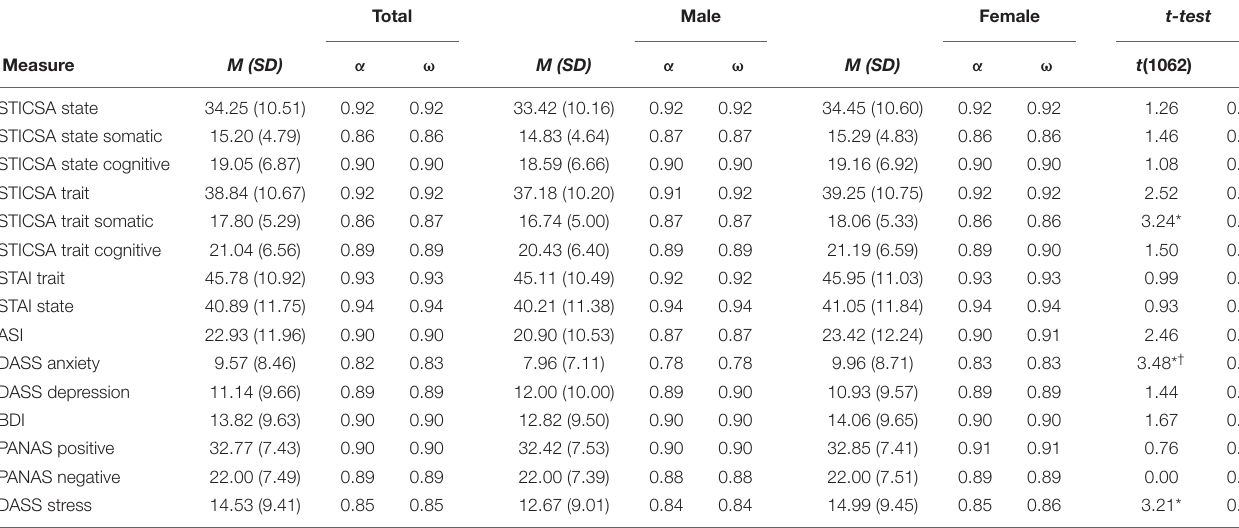
TABLE 4 | Descriptive statistics and internal consistencies for measures collapsed across gender, as well as separated by gender, and between-subjects t -tests examining gender